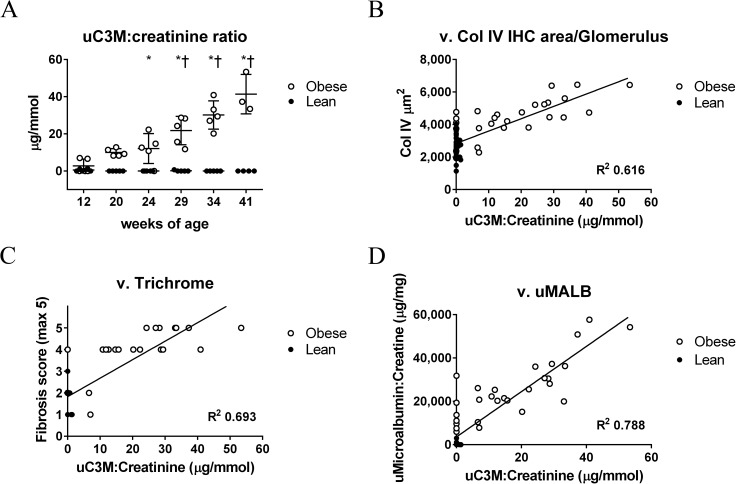
Levels of urinary Collagen type III breakdown product (uC3M) positively correlate with renal fibrosis and renal function decline in ZSF1 rats.(A) Levels of uC3M as determined by ELISA for the MMP9-generated neoepitope KNGETGPQGP, normalized to urine creatinine levels, in all animals over the study duration. Correlation of uC3M to creatinine levels versus Collagen type IV staining area per glomerulus (B), semi-quantitative trichrome staining (C), and microalbumin to creatinine ratios (D). R2 values, shown, were determined by linear regression of all values with obese animals represented by open circles and lean animals represented by filled circles.